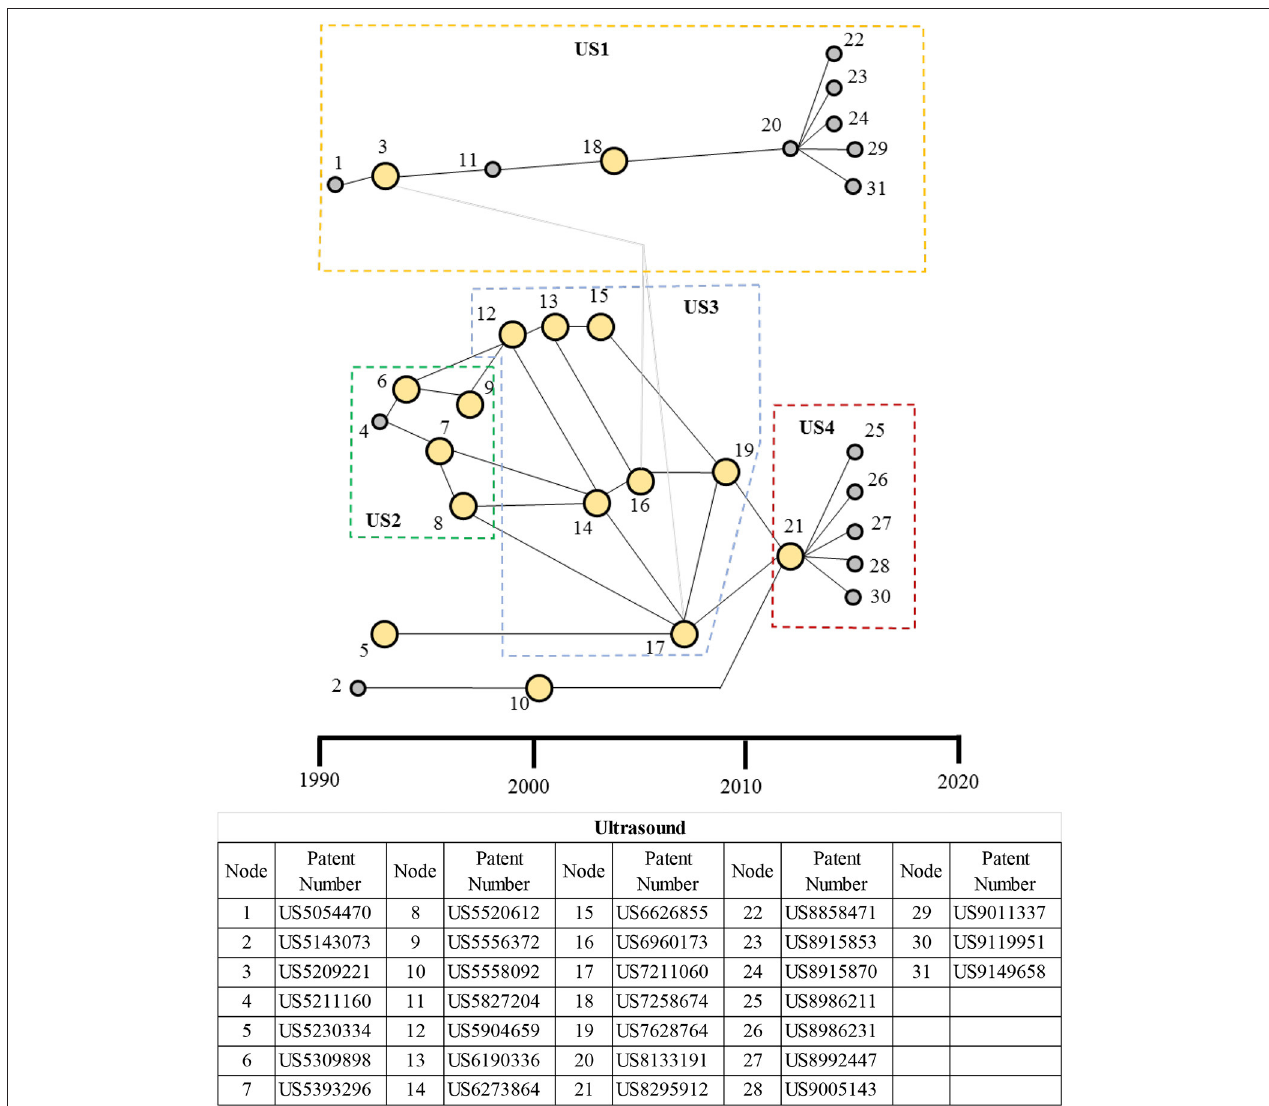
FIGURE 10 | Main paths for the ultrasound therapeutic domain. US1: A patent cluster for tissue lesioning; US2: bone growth technologies; US3: a patent cluster for wound-healing technologies; and US4: a patent cluster for nerve-stimulation technologies. The table presents node numbers with corresponding patents and their description. High-persistence patents are shown as bigger yellow circles, whereas the low-persistence patents are shown as smaller gray